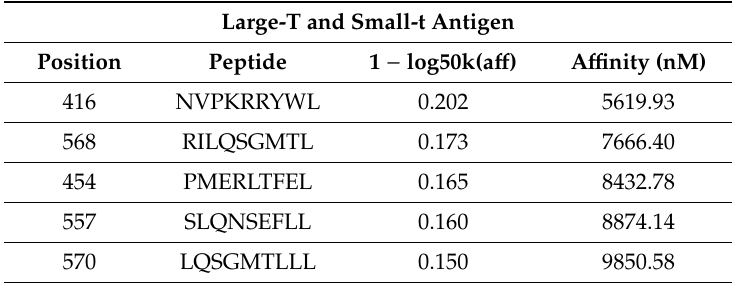
Table 2. High and moderate a ffi nity peptide sequences derived from BK polyomavirus (BKPyV) large T antigen and small t antigen that may be presented by the HLA-E*01:01 allelic variant as identified by the machine-learning bioinformatics algorithm NetMHC4.0. Position: residue number (starting from 0); peptide: amino acid sequence of the potential